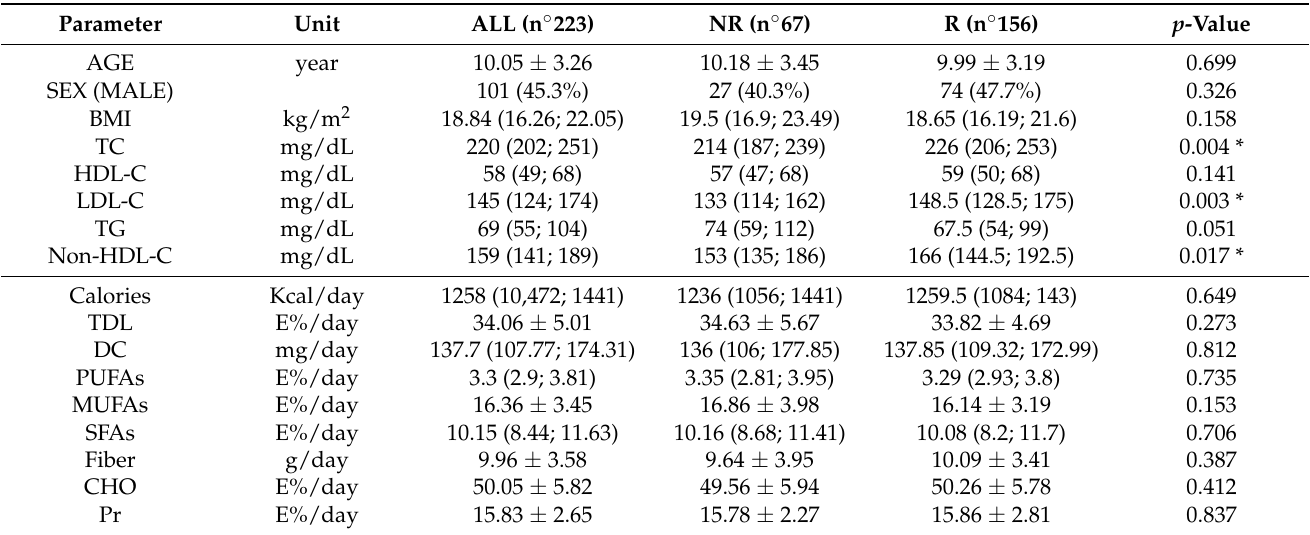
Table 1. Baseline characteristics of the study